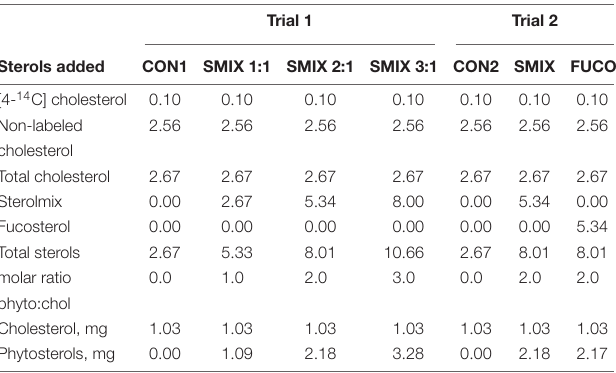
TABLE 2 | Sterols added to the experimental feeds by coating ( µ mol g − 1 or, if indicated, mg g − 1 ). Trial 1 Trial 2 Sterols